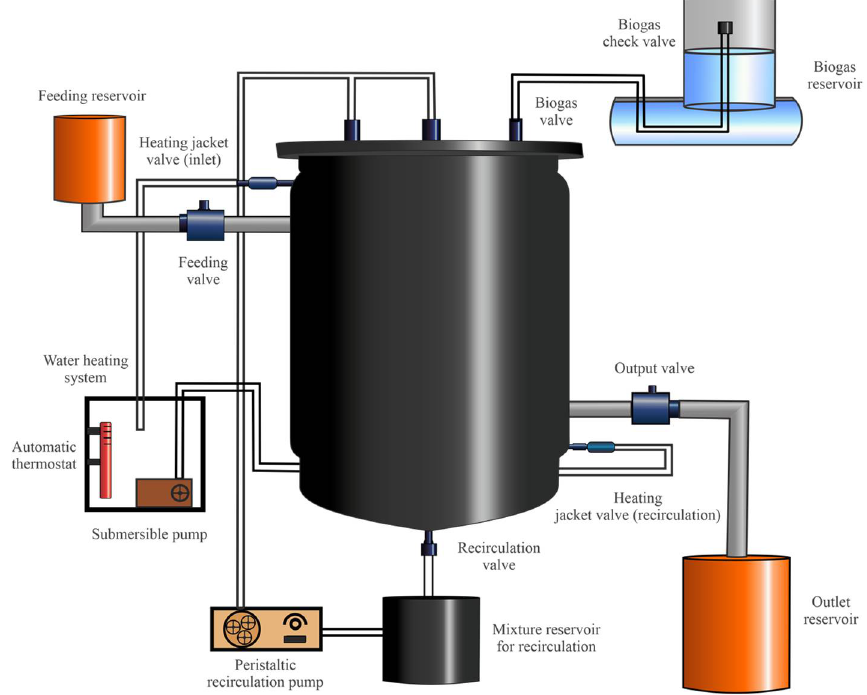
Figure 1. Anaerobic reactor for the digestion of industrial citrus solid waste (ISCW) with cattle manure (CM). Table 1. Characterization of cattle manure and industrial solid citrus